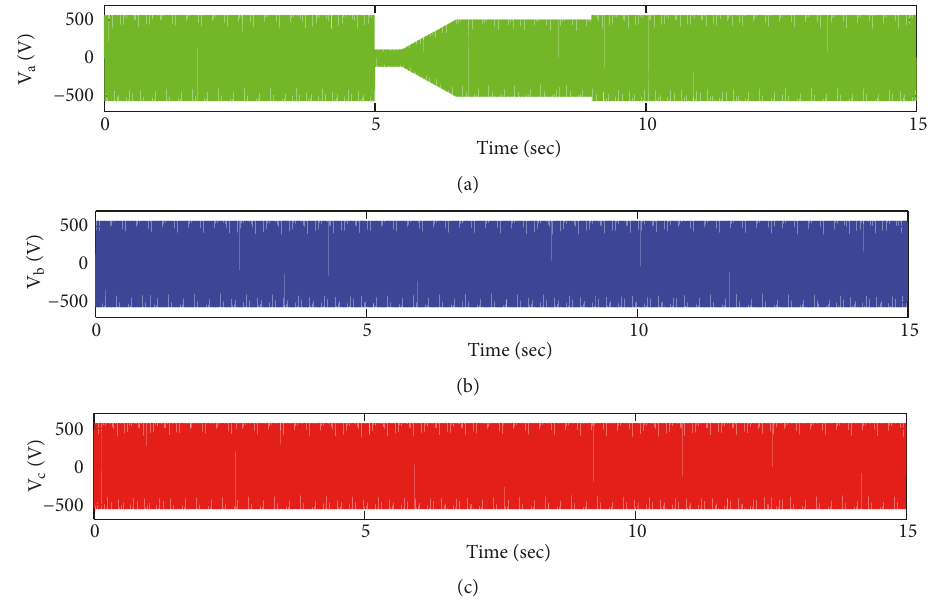
Figure 13: The grid voltage profile during a single-phase voltage drop, (a) phase A, (b) phase B, and (c) phase C.